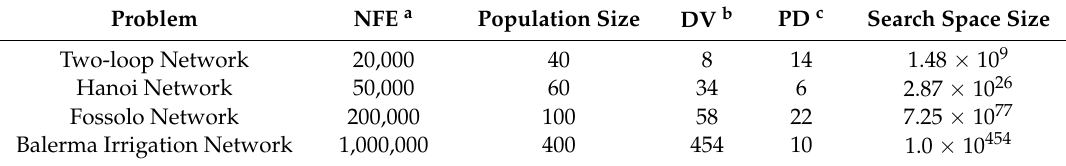
Table 6. Computational budgets and sizes of search space for benchmark design problems.